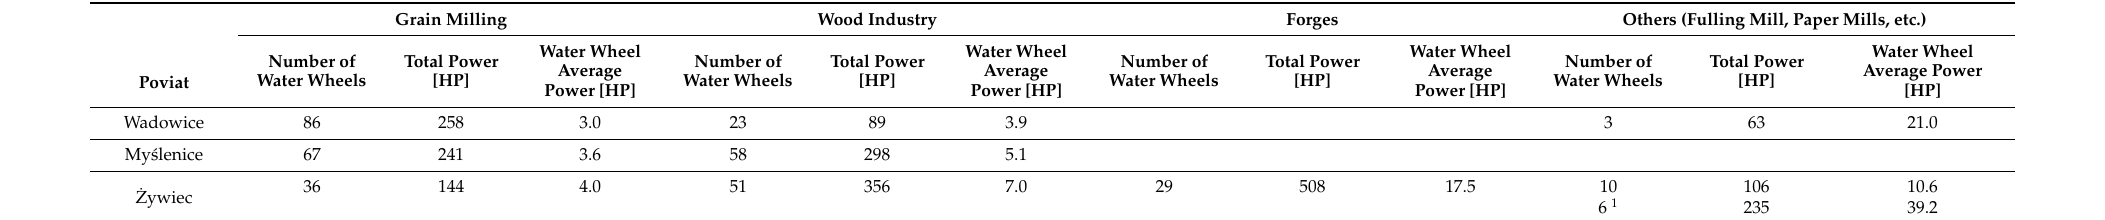
Table 1. Power of watermills in selected poviats in Galicia in 1886